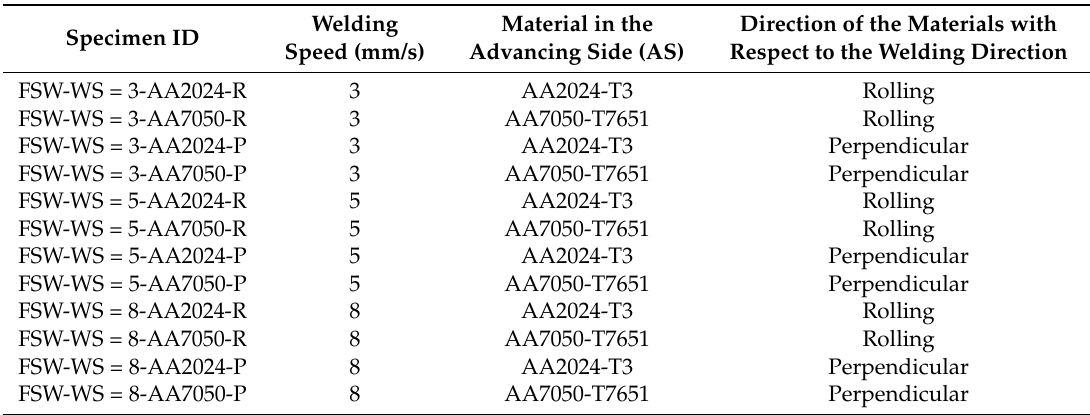
Table 3. Specimens’ ID and welding parameters.